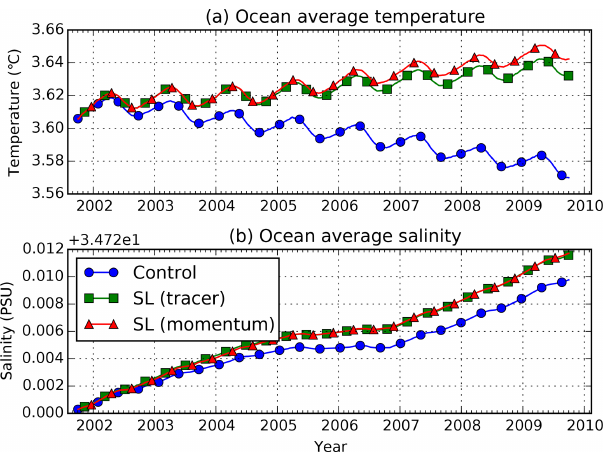
Figure 8. (a) Ocean-average temperature ( ◦ C) and (b) salinity (PSU) over time for the test cases of Sect. 5.2. Although conser- vation is not guaranteed by semi-Lagrangian advection, long-term trends are similar between the semi-Lagrangian runs and the control run.